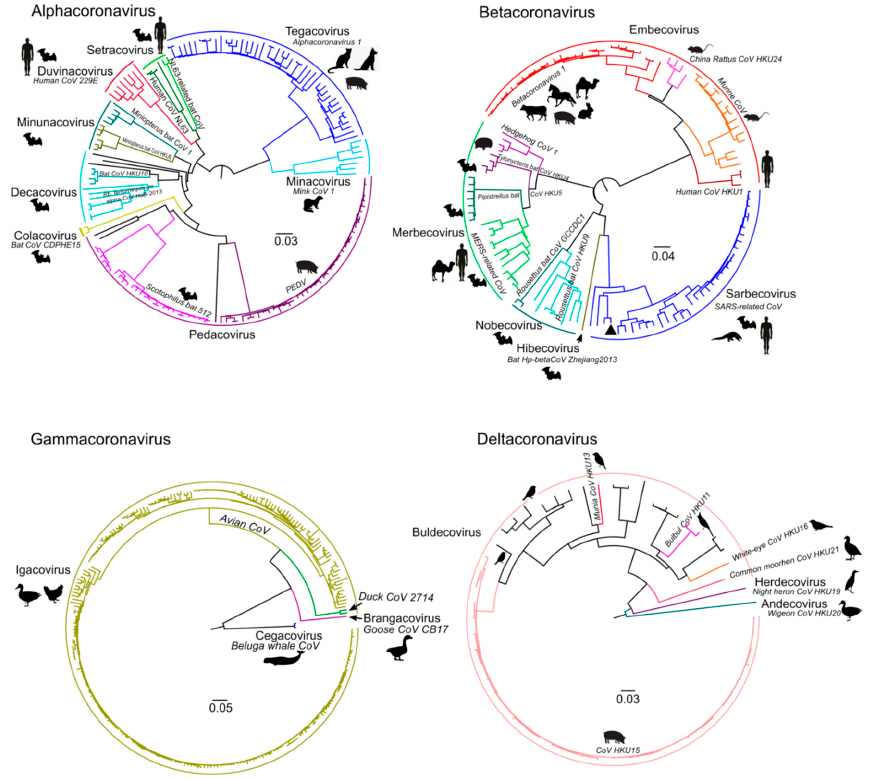
Figure 2. Datasets created for the four genera of coronaviruses represented as maximum likelihood phylogenetic tree of ORF1b, which contains RdRp. Subgenera names and species names are noted. The silhouettes of major hosts infected by virus species are shown near the tips. Taxonomy reflects the ICTV 2020 update. Not all genomes are formally assigned to species yet, and for some, the host data is lacking.